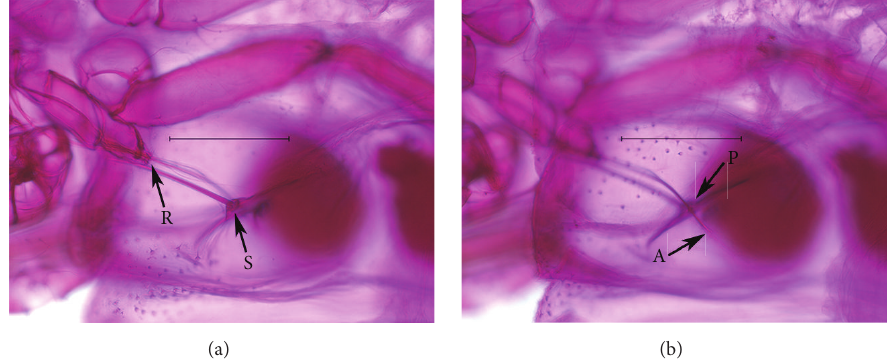
Figure 5: Stylets of a defensive nymph stuck through the epidermis of a lepidopteran larva: (a) upper focus; (b) lower focus. Capital letters on the figure indicate the apex of the rostrum of the attacking aphid (R), the socket of a seta on the epidermis of the lepidopteran larva (S), the apices of the aphid’s stylets (A), and the presumed puncture point (P). The stylets are extended from the apex of the rostrum (R) to the point A through the point P below the socket (S). Scale bars: 100 𝜇 m.